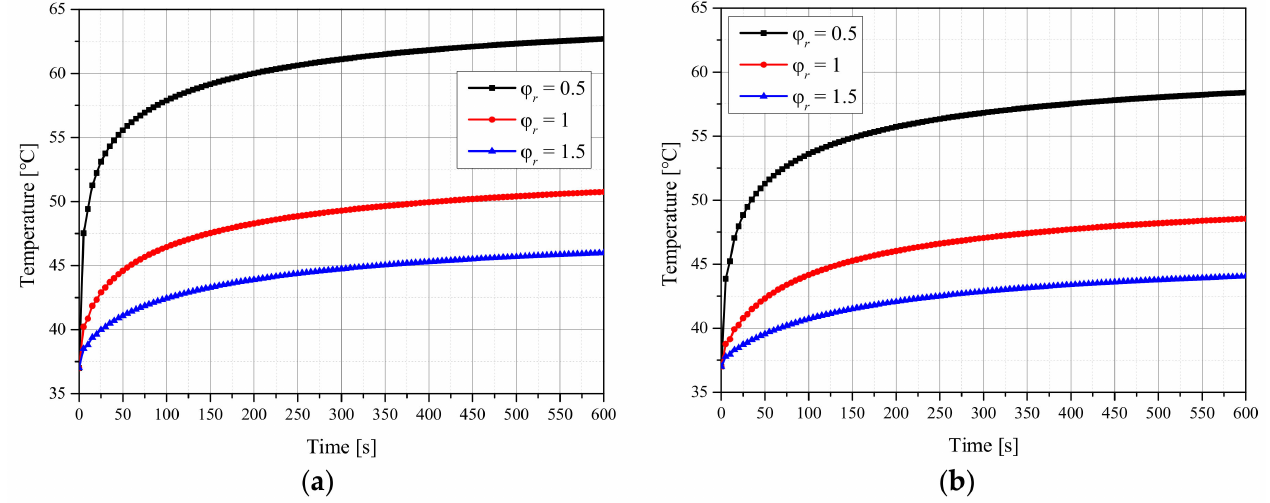
Figure 1. ( a ) Gaussian profile. ( b ) Top-hat profile. Temperature change of the tumor tissue for different radius ratios ( f v = 10 − 6 , P l = 100